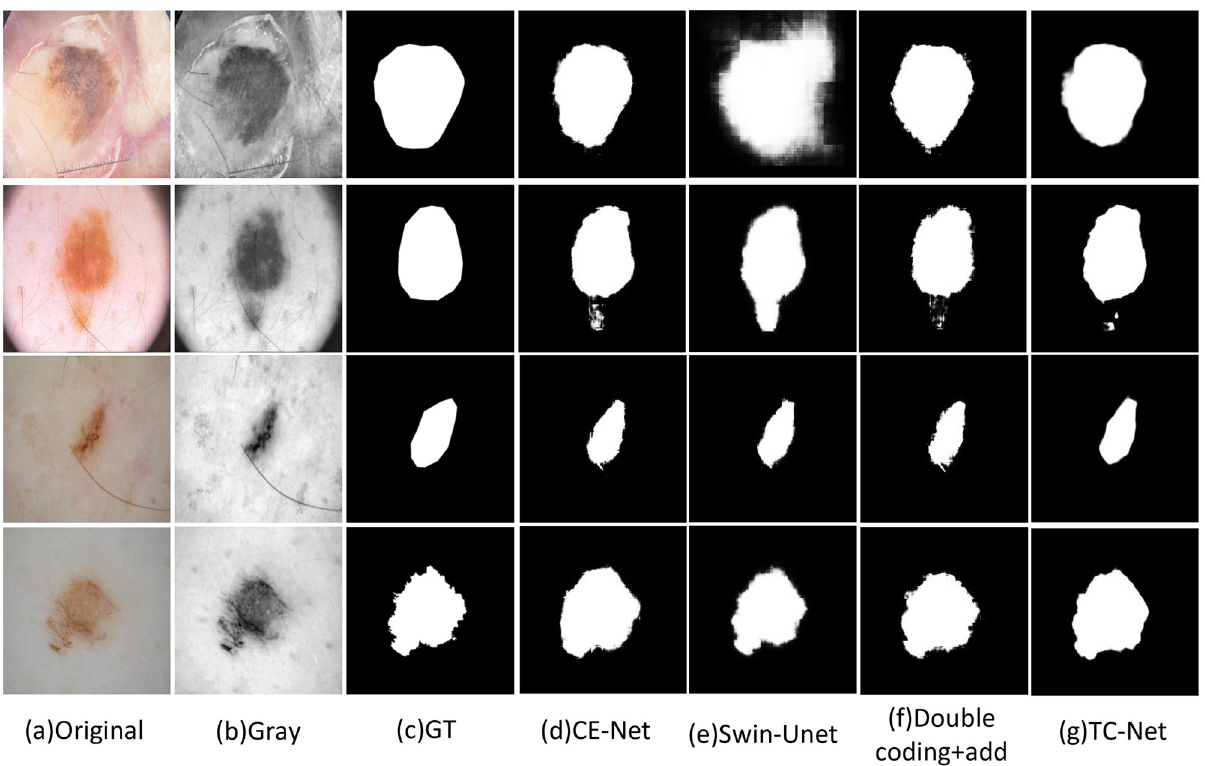
Fig 4. Visual analysis of ablation experiment on ISBI2016. (a) Original. (b) Gray. (c) GT. (d) CE-Net. (e) Swin-Unet. (f) Double coding+add. (g) TC-Net.